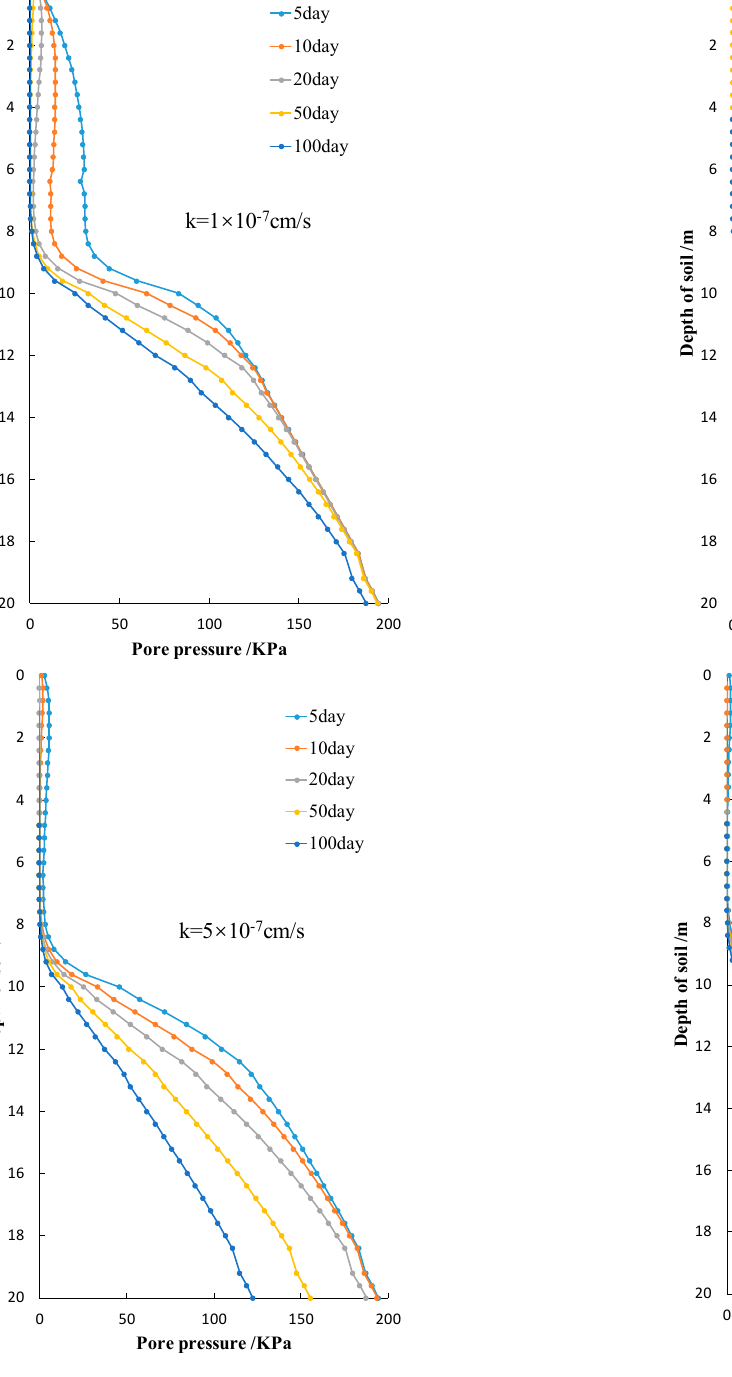
Figure 6. Vertical distribution of soil pore water pressure at corner of square column at siphon hole spacing d = 1 m.